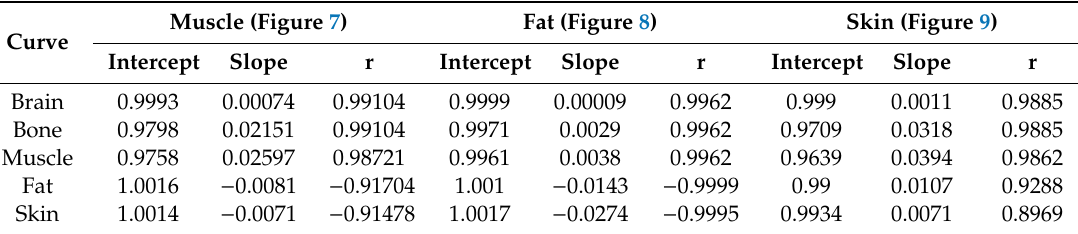
Table 4. Regression results of normalized temperature and tissue thickness change in Figures 7–9. Muscle (Figure 7) Fat (Figure 8) Skin (Figure Curve